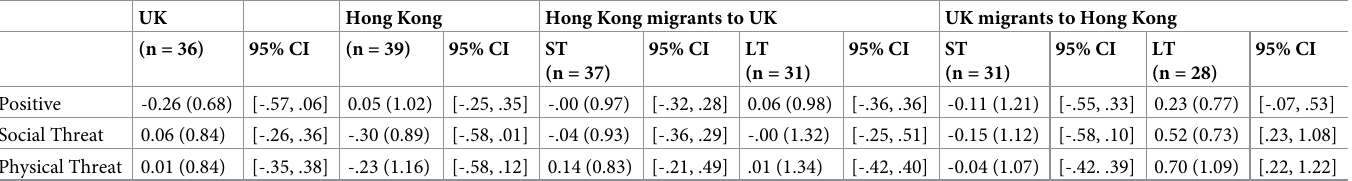
Table 4. Means (standard deviation) on emotional stroop task (median emotional interference scores, seconds). UK